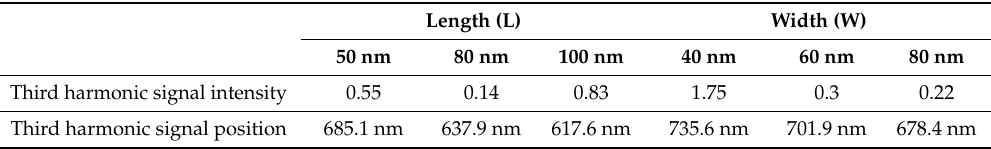
Table 2. Effect of the geometric variations in the structural parameters on the generated third harmonic signal intensity and position for c-GST.